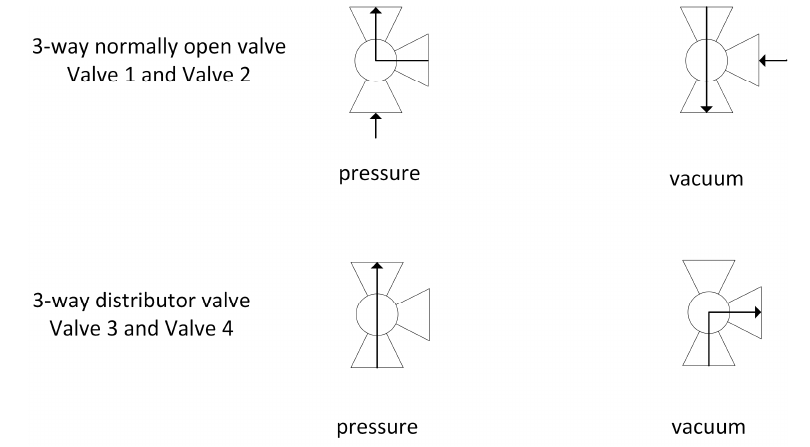
Figure 2. Flow directions Schematics of the normally open and distributor three-way valve under pressure and vacuum conditions.